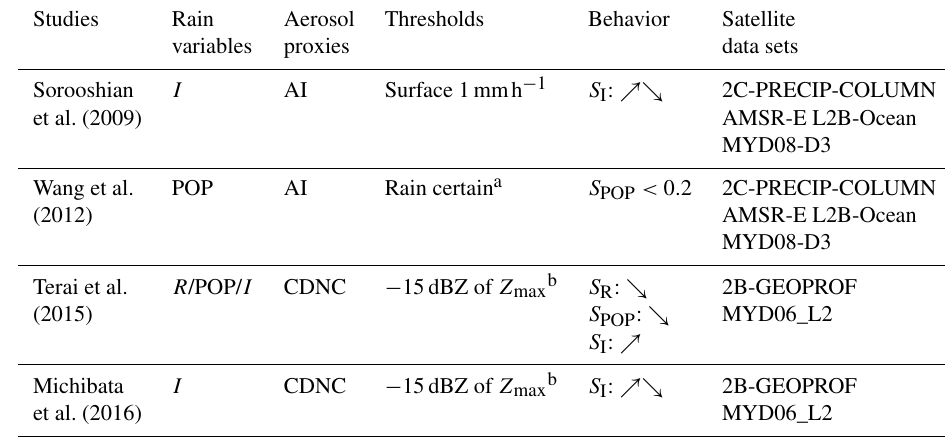
Table 1. The summary of previous satellite studies for estimating precipitation susceptibility. Studies Rain Aerosol Thresholds Behavior Satellite variables proxies data sets